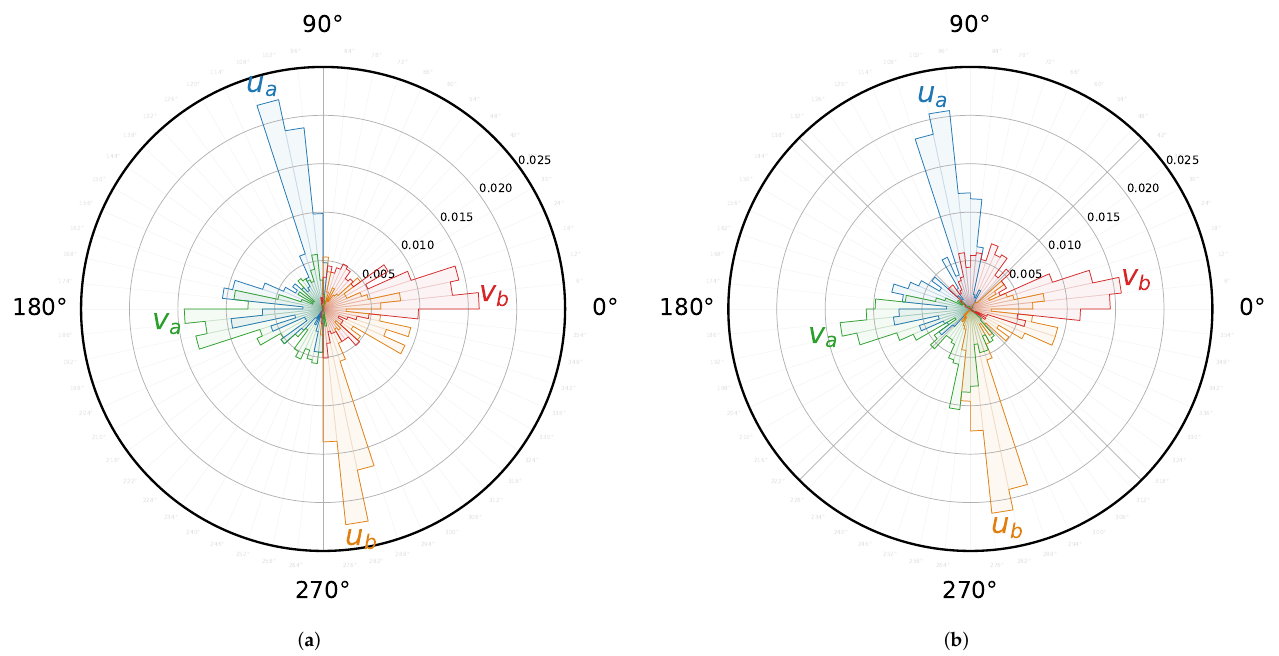
Figure 11. Histograms of the pointer orientations obtained by ( a ) fixed and ( b ) soft edge point assignment strategies. The histograms are normalized and the bin width is 6 ◦ . Only the pointers from the shape descriptors that form the final detection results are counted. The boundaries between the pointers of the same type are visualized. This figure is best zoomed in for